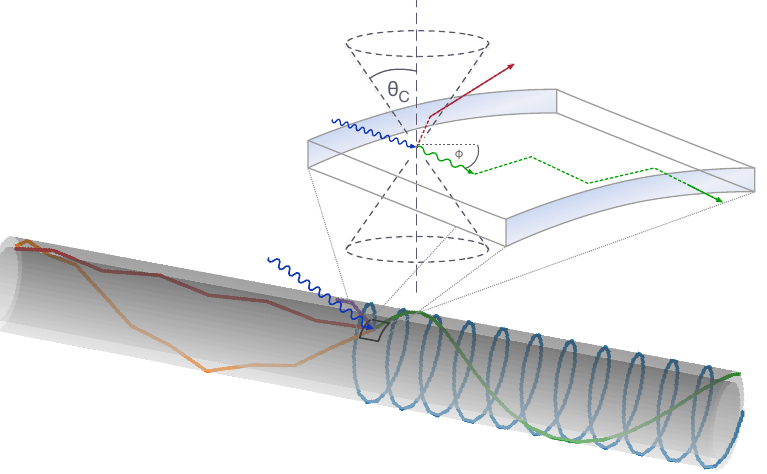
Figure 2. Visualization of several photon paths propagating in the wall of the WOM tube simulated with a GPU-based ray-tracing algorithm [13]. The photons are generated inside the paint layer of the tube in response to the incident UV photons (blue). Their attenuation probability depends on the effective path length, which, in turn, depends on the emission angle. In the inset, a UV photon (blue) is shown, which is absorbed and re-emitted in the material (green) or lost (red). The critical angle for the re-emitted photon defines a loss cone (gray dashed